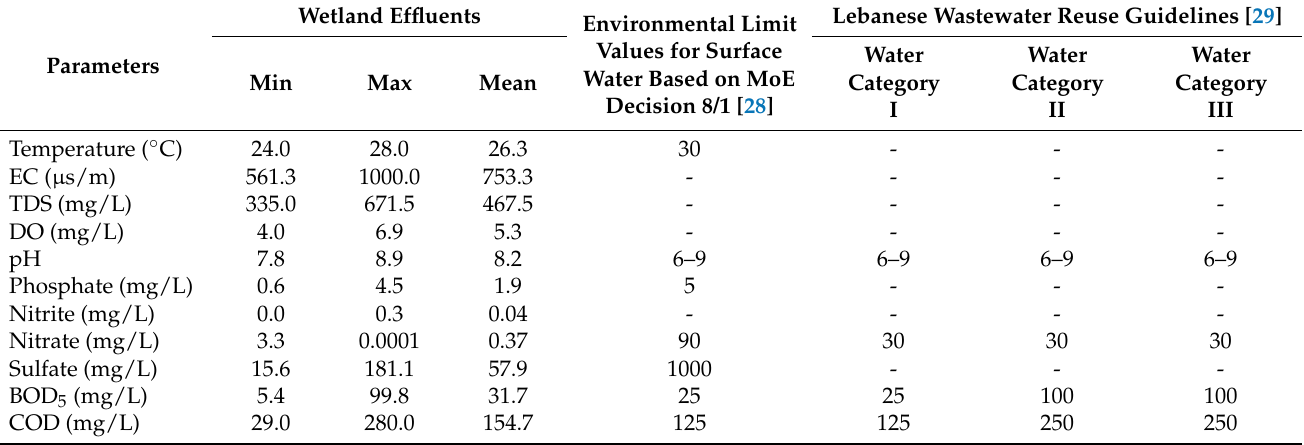
Table 2. Minimum, maximum, and mean value of water quality parameters collected from the wetland effluent compared to recommended limits.